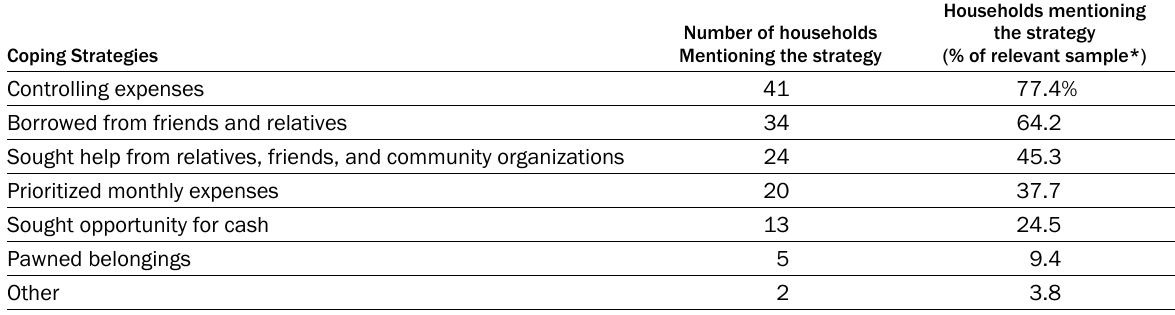
Coping Strategies